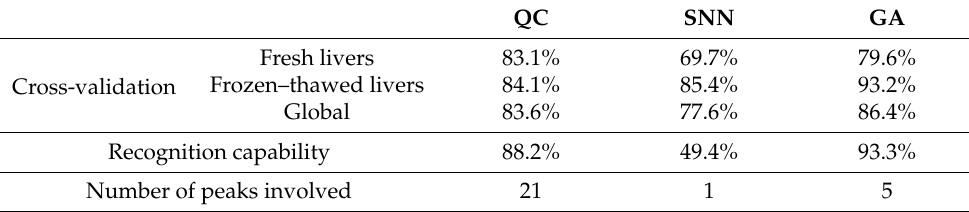
Table 1. The evaluation results of the QC, SNN, and GA algorithms to discriminate fresh and frozen–thawed livers based on the protein fingerprint. QC SNN